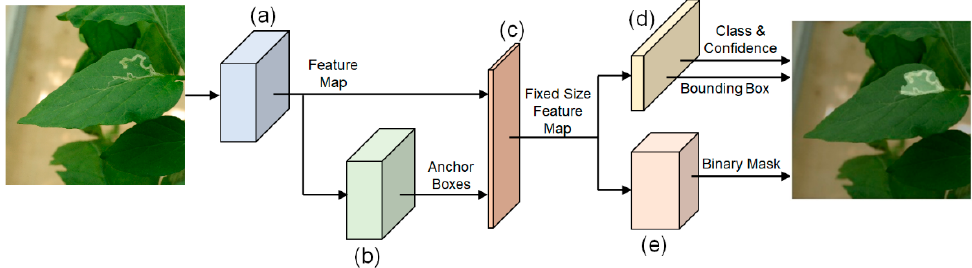
Figure 2. Developed DNN structure using transfer learning with Mask R-CNN. ( a ) ResNet101, ( b ) Region proposal network, ( c ) Region of interest pooling, ( d ) Fully connected layer, ( e ) Feature pyramid